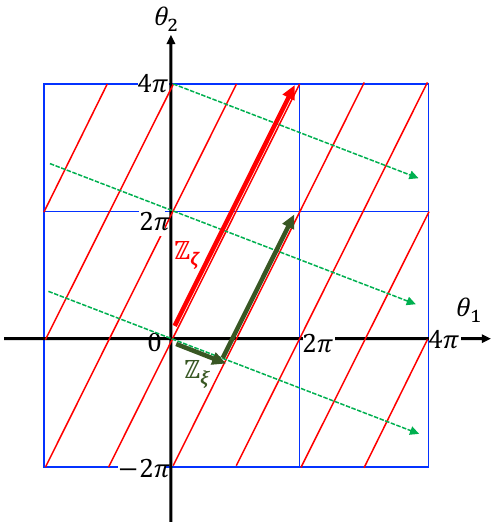
Figure 1 . Illustration of the discrete gauge transformations Z (cid:16) (thick red arrow) and Z (cid:24) (thick black arrow) in the moduli space of (cid:18) i . As an example, here we take k 1 = 1 and k 2 = 2. The red lines are the coordinate axis of (cid:16) , while the green lines are the coordinate axis of (cid:24) . Note that @(cid:18) i =@(cid:16) = k i are integers, while @(cid:18) i =@(cid:24) are kinetic-metric-dependent continuous numbers, so the two coordinate axes are not orthogonal to each